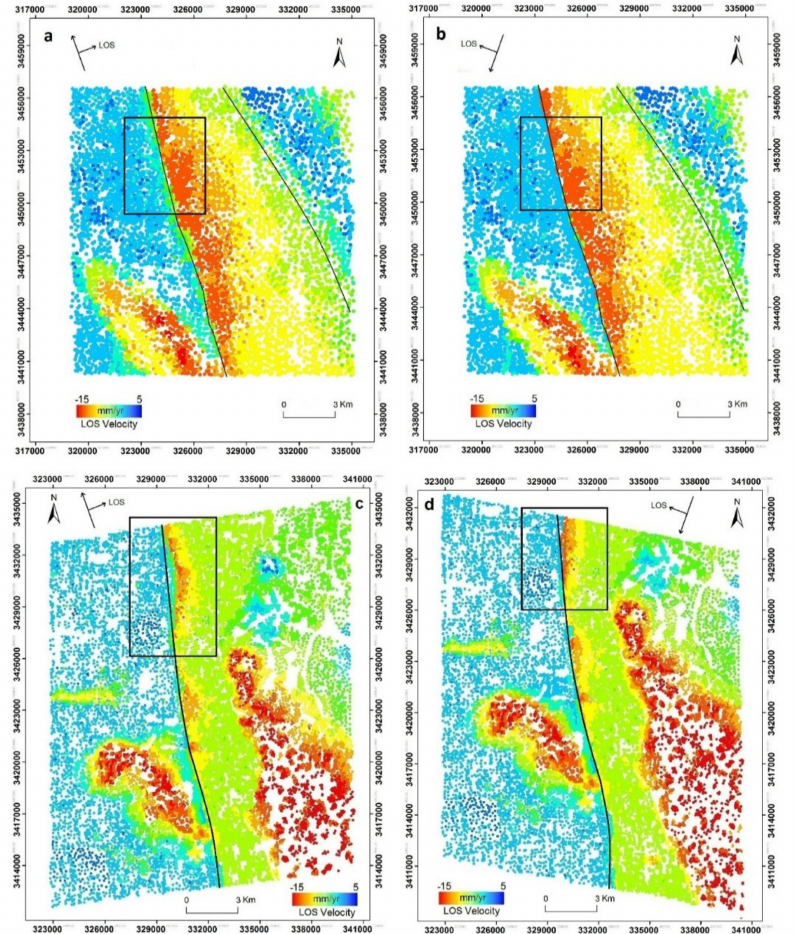
Figure 5. The LOS displacement map from the PSI method. ( a , c ) ascending images; ( b , d ) descending images. A dark line marks the Anar fault. The rectangles indicate the areas where the azimuth offset method is